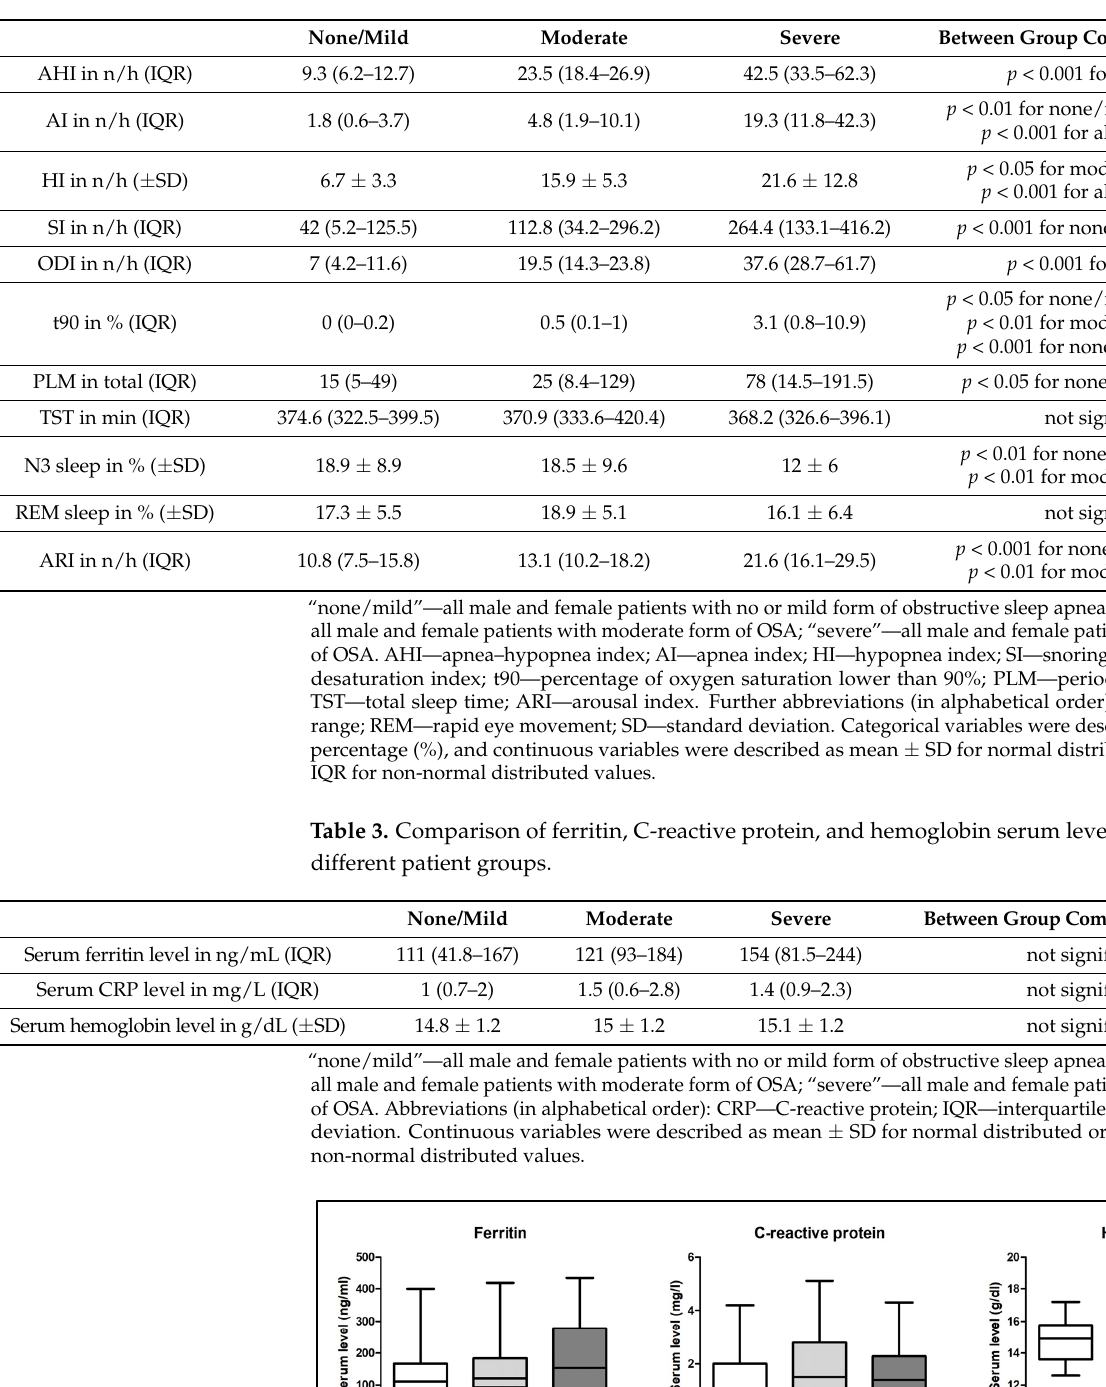
Table 2. Comparison of sleep parameters among the three different patient groups.